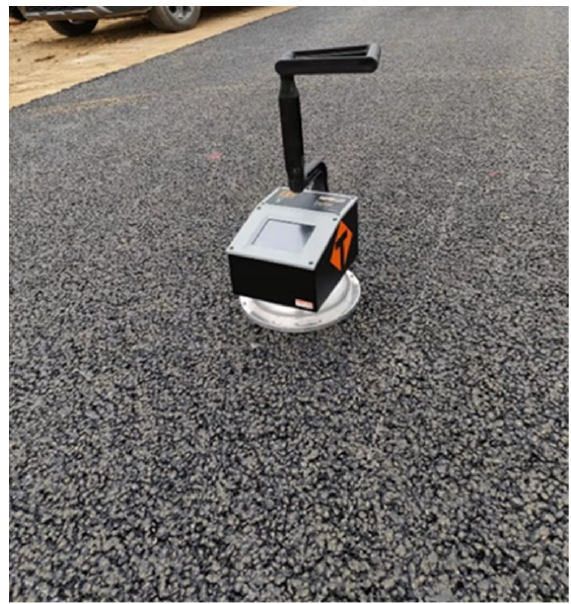
Figure 2. Non ‐ nuclear density gauge (PQI 380). Figure 2. Non-nuclear density gauge (PQI